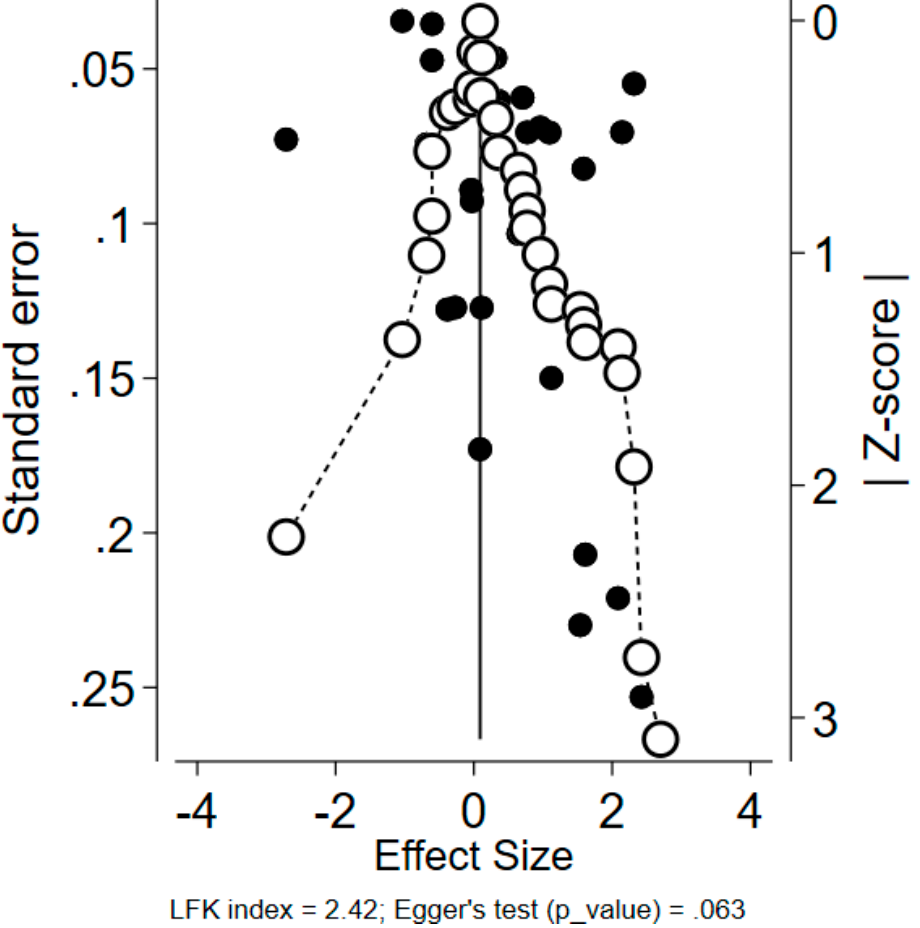
Figure 6. DOI plot with LFK index = 2.42, along with the funnel plot and Egger’s test ( p -value = 0.063) .